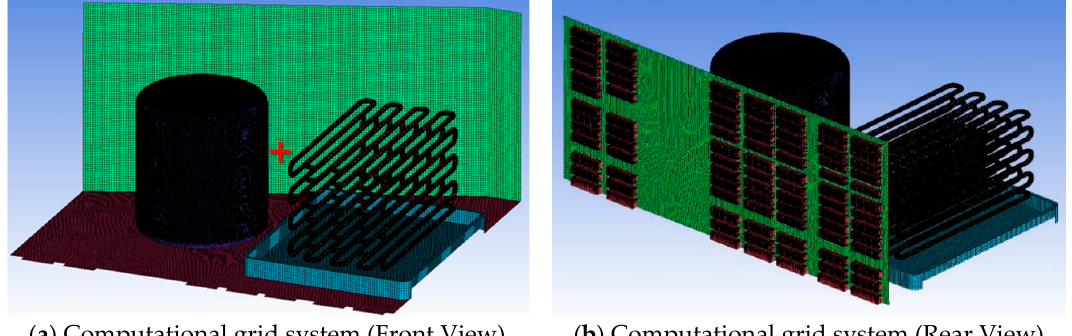
Figure 6. Computational grid system.